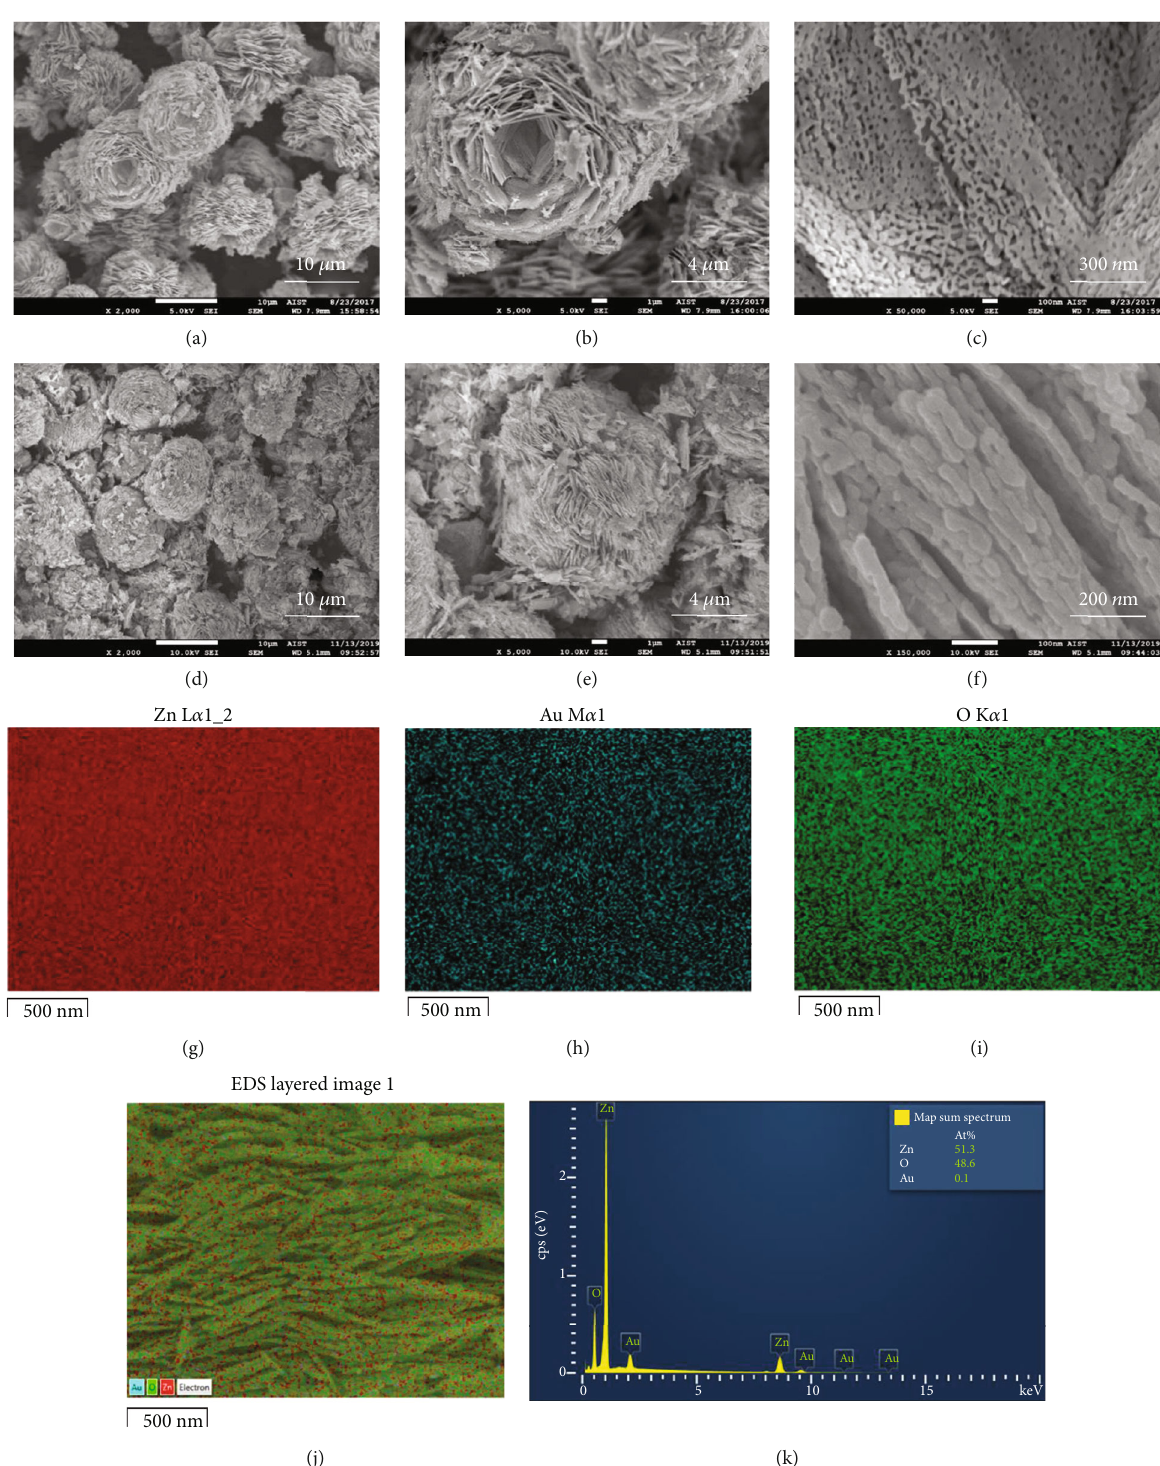
Figure 3: (a, b) SEM images of fl ower-like ZnO with the di ff erent scale bars, (d – f) SEM images of Au/ZnO-5 composite di ff erent scale bars, (g – i) Zn, Au, and O elemental map images, (j) SEM/EDS image, and (k) EDS spectrum Au/ZnO-5